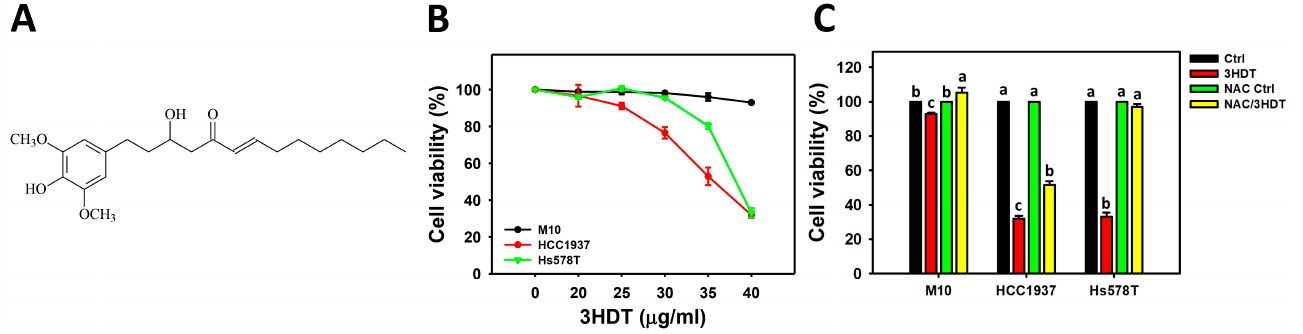
Figure 1. Cell viabilities of 3HDT treatment. ( A , B ) Structure and CCK-8 assay of 3HDT for 24 h. ( C ) CCK-8 assay of N -acetylcysteine (NAC)/3HDT. 3HDT and NAC/3HDT indicate 24 h 3HDT treatment (40 µ g/mL) without and with NAC pretreatment, respectively. 3HDT was dissolved in DMSO. The DMSO concentration of different 3HDT treatments was adjusted to the same (0.1%). Control (Ctrl) indicates the vehicle control containing 0.1% DMSO. NAC control (NAC Ctrl) indicates the NAC/0.1% DMSO. Data: mean ± SD ( n = 3). Treatments differ significantly for multiple comparisons when the lower-case letters are not overlapping ( p < 0.05). Different treatments of the same cell line were compared for statistical analysis. In the example of M10 cells, NAC/3HDT, NAC control, and 3HDT are assigned with “a, b, c” by the JMP software, indicating significant differences between each other because the letters are non-overlapped. In contrast, control and NAC control show the same letter “b”, indicating a non-significant difference.